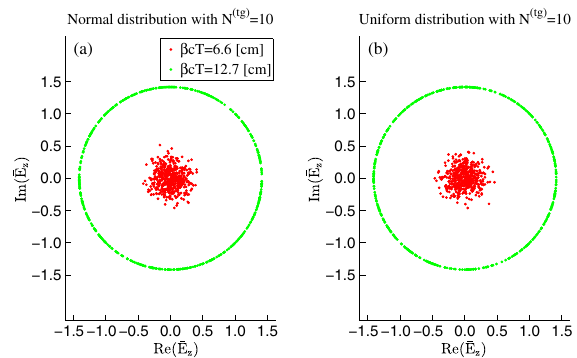
FIG. 3. The real part and the imaginary part of the wakefield in the linear regime (at β cT ¼ 6 . 6 cm) and in the nonlinear regime (at β cT ¼ 12 . 7 cm). The wake is triggered by a bunch consisting of N ð tg Þ ¼ 10 electrons that are spread either (a) normally or (b) uniformly with standard deviation of one and a half resonance wavelengths ( 2 ψ ¼ 3 π ). Also, the number of the circles at β cT ¼ 6 . 6 cm and β cT ¼ 12 . 7 cm equals to the number of the numeri- 500 cal simulations, N exp ¼